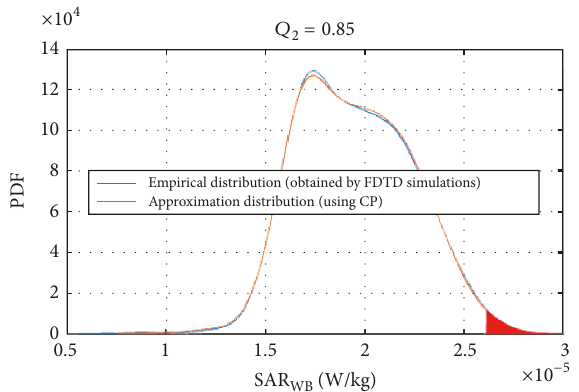
Figure 18: Comparison between the approximate and the empirical distribution.